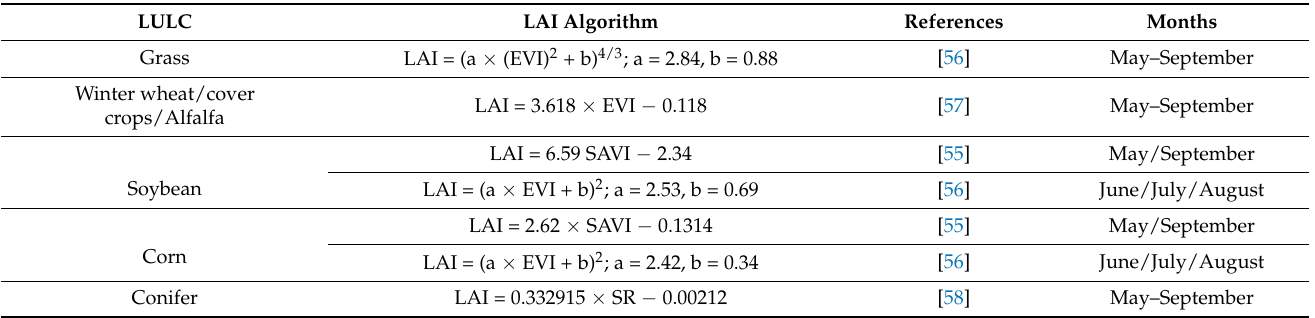
Table 3. Crop-specific LAI algorithms used in the study. Months represent the corresponding time intervals for which the LAI algorithms were